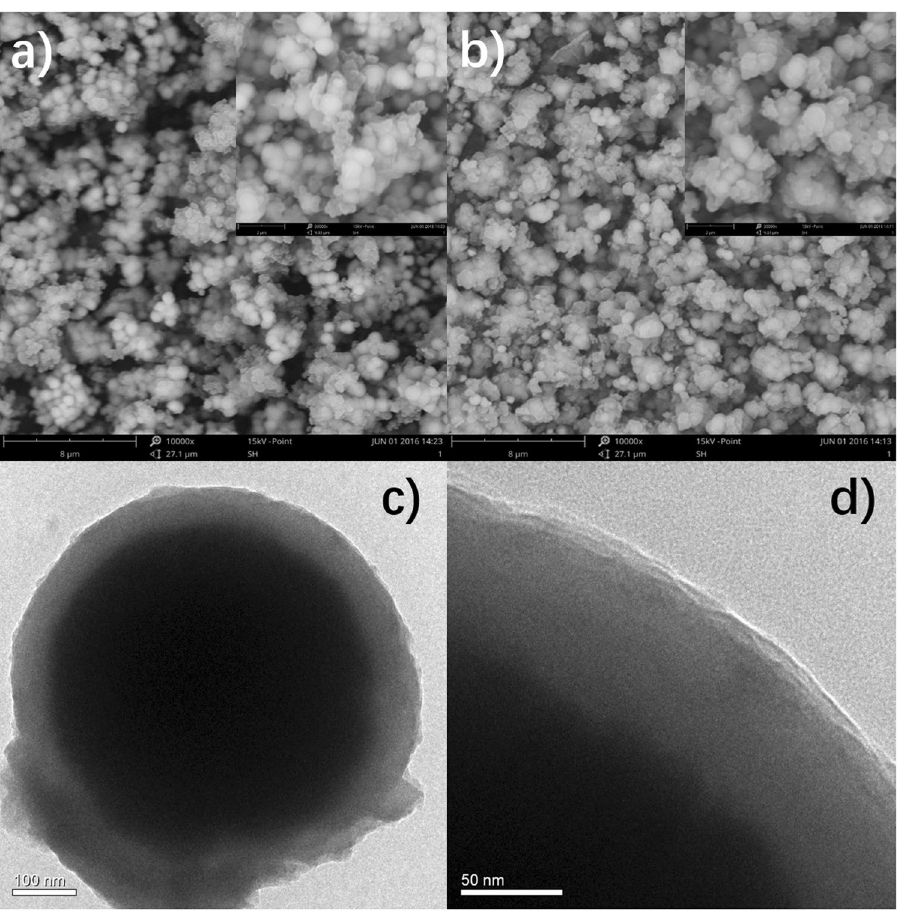
Figure 1. SEM images of ( a ) Fe 3 O 4 @PDA and ( b ) Fe 3 O 4 @PDA@UiO-66-NH 2 ; TEM images of ( c , d ) Fe 3 O 4 @ PDA@UiO-66-NH